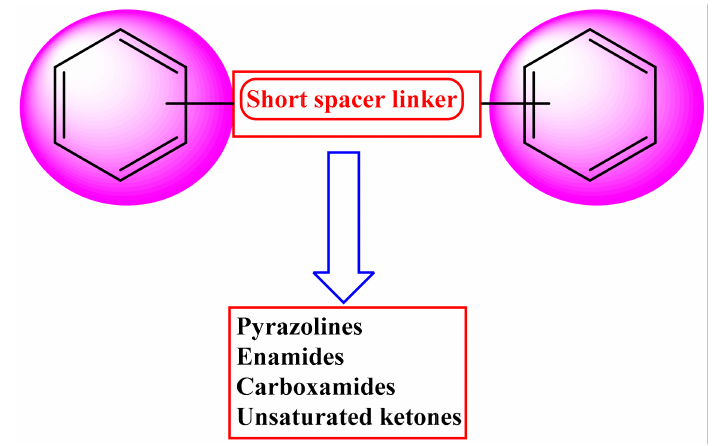
Figure 1. General blueprint of the design of MAO-B